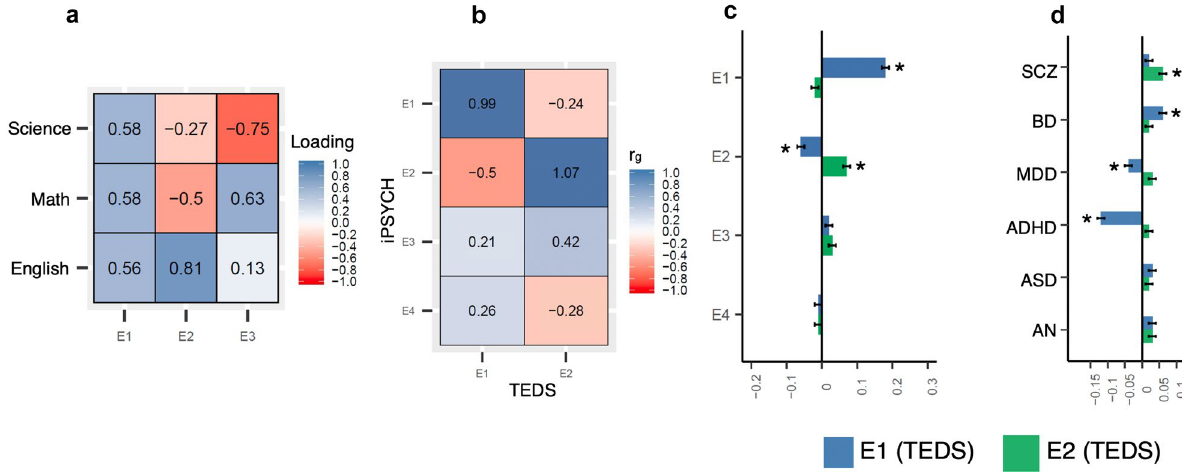
Figure 5. Replication analysis in TEDS. ( a ) Pearson correlations of E-factors with subject-specific school grades; ( b ) Genetic correlations of TEDS E-factors with iPSYCH E-factors estimated using bivariate LD score regression; ( c ) Associations of polygenic scores for E1, E2, E3 and E4 (based on iPSYCH SNP weights) with E1 and E2 in TEDS tested using linear regression; standardized effect sizes (beta) and standard errors are shown; ( d ) Associations of polygenic scores for the six psychiatric disorders with E1 and E2 in TED; standardized effect sizes (beta) and standard errors are shown. SCZ schizophrenia, BD bipolar disorder, MDD major depressive disorder, ADHD attention deficit hyperactivity disorder, ASD autism spectrum disorder, AN anorexia nervosa. Star symbols indicate statistical significance after multiple testing corrections (P < 0.006 for panel c and P < 0.004 for d